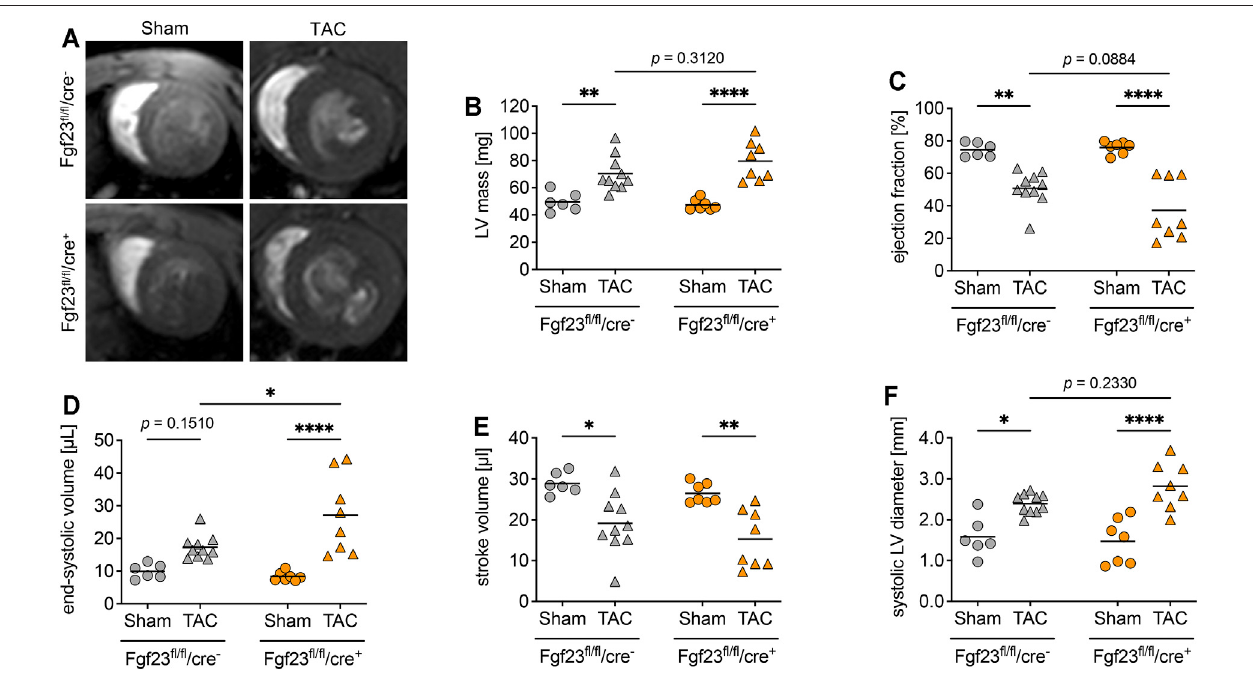
FIGURE 5 | Cardiac myocyte-speci fi c Fgf23 knockout worsen high blood pressure-induced cardiac dysfunction. (A) Representative cardiac cross-sectional magnetic resonance images of sham and TAC-operated Fgf23 fl / fl /cre − and Fgf23 fl / fl /cre + mice. (B) Left ventricular (LV) mass is enhanced in TAC-operated Fgf23 fl / fl /cre − and Fgf23 fl / fl /cre + mice. (C) Ejection fraction is reduced after TAC surgery, which is more pronounced in Fgf23 fl / fl /cre + mice. (D) TAC increases the end-systolic volume (ESV) in both genotypes, with ESV being signi fi cantly higher in Fgf23 fl / fl /cre + mice compared to controls after TAC. (E) Stroke volume is reduced in both genotypes afterTAC. (F) SystolicLVdiameterisenhancedafterTAC,whichismorepronouncedinFgf23 fl / fl /cre + mice.Dataisgivenasscatterdotplotswithmeans;* p < 0.05,** p < 0.01, and **** p < 0.0001 analyzed by Two-way ANOVA followed by Tukey ’ s multiple comparison test; n (cid:2) 6 – 10 mice per